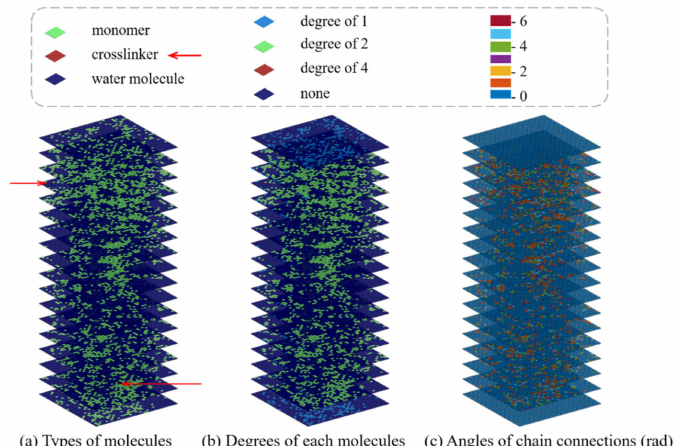
Figure 9. Schematics of slices plot illustration of three sublayers incorporating the geometric and physical features. ( a ) Representation of the type of molecules. ( b ) The degree of each molecule, that is, the number of connections per molecule. ( c ) The angle of chain